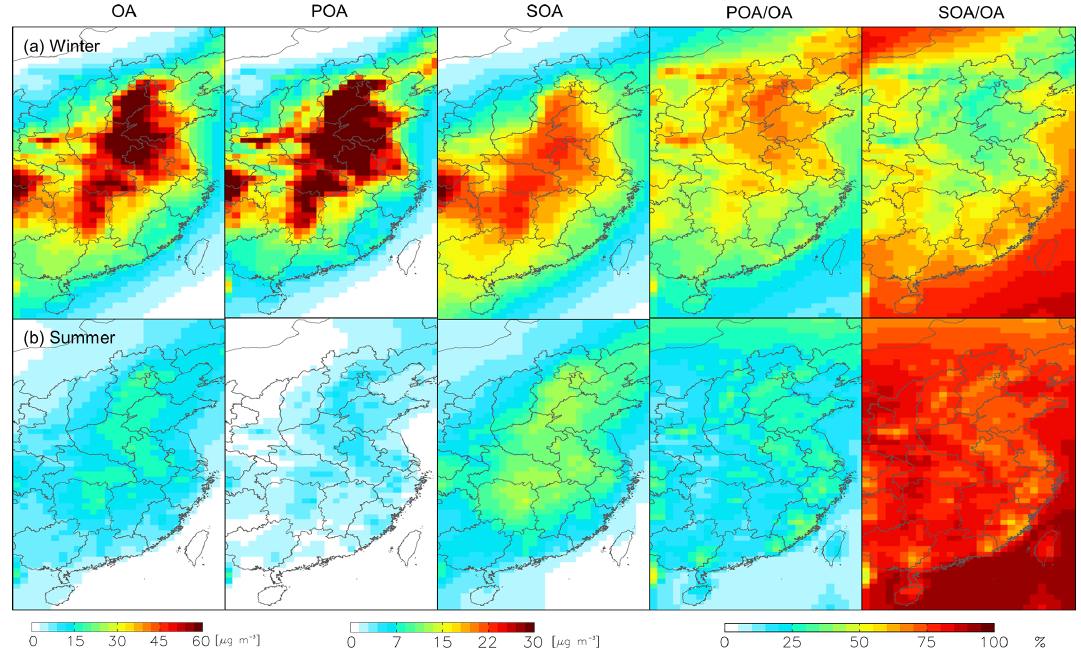
Figure 6. Seasonal mean mass concentrations of OA, POA, and SOA and the mass fractions of POA and SOA simulated by the Cp_R1 + 2 + 3 simulation in (a) winter and (b)